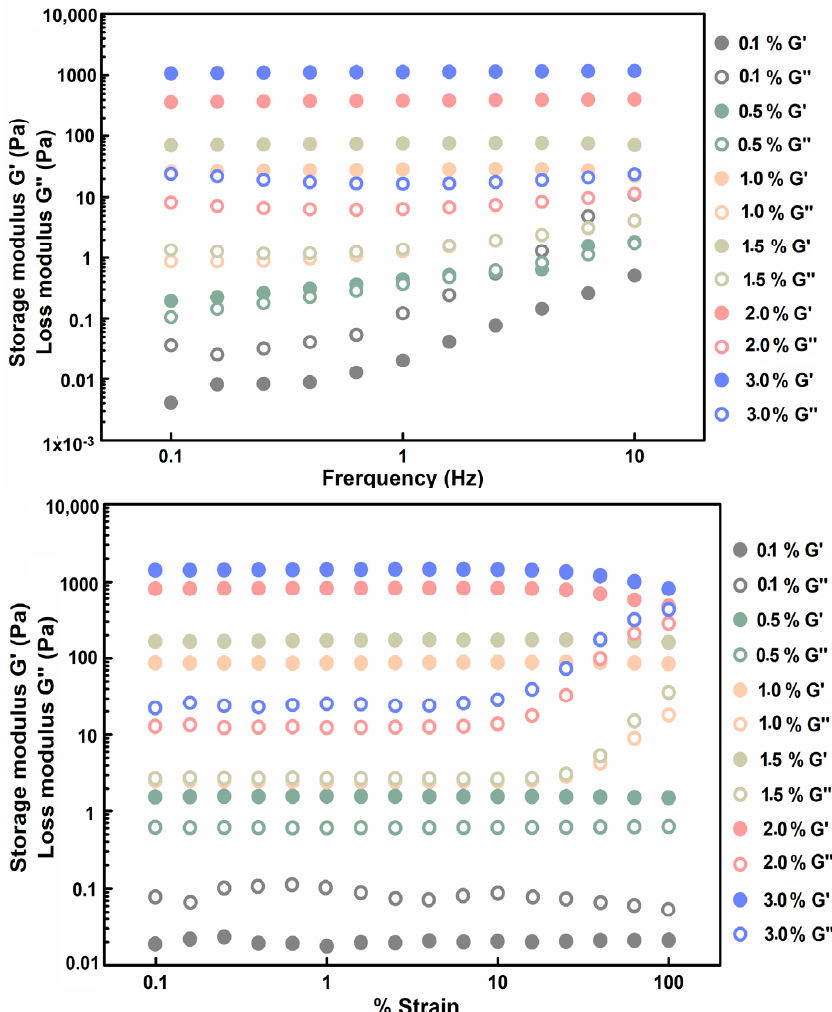
Figure 2. Microrheology results of different concentrations of gelatin ( w / v ). Storage and loss moduli, G' and G'', of the 3.0% gelatin (blue), 2.0% gelatin (rose), 1.5% gelatin (yellow), 1.0% gelatin (pink), 0.5% gelatin (green), and 0.1% gelatin (grey).